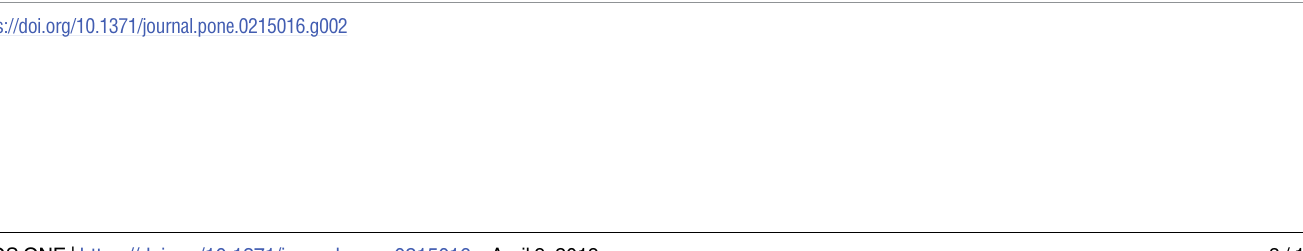
PLOS ONE | https://doi.org/10.1371/journal.pone.0215016 April 9,